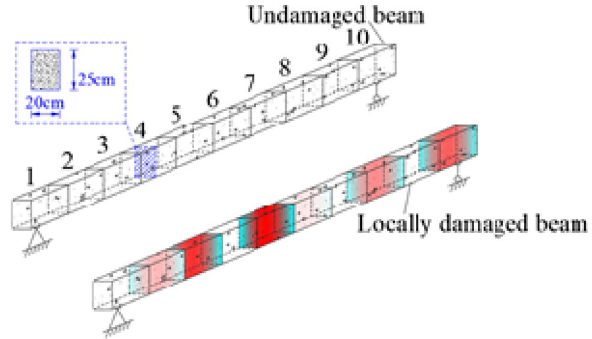
Figure 3. Numerical model of the simply supported beam.